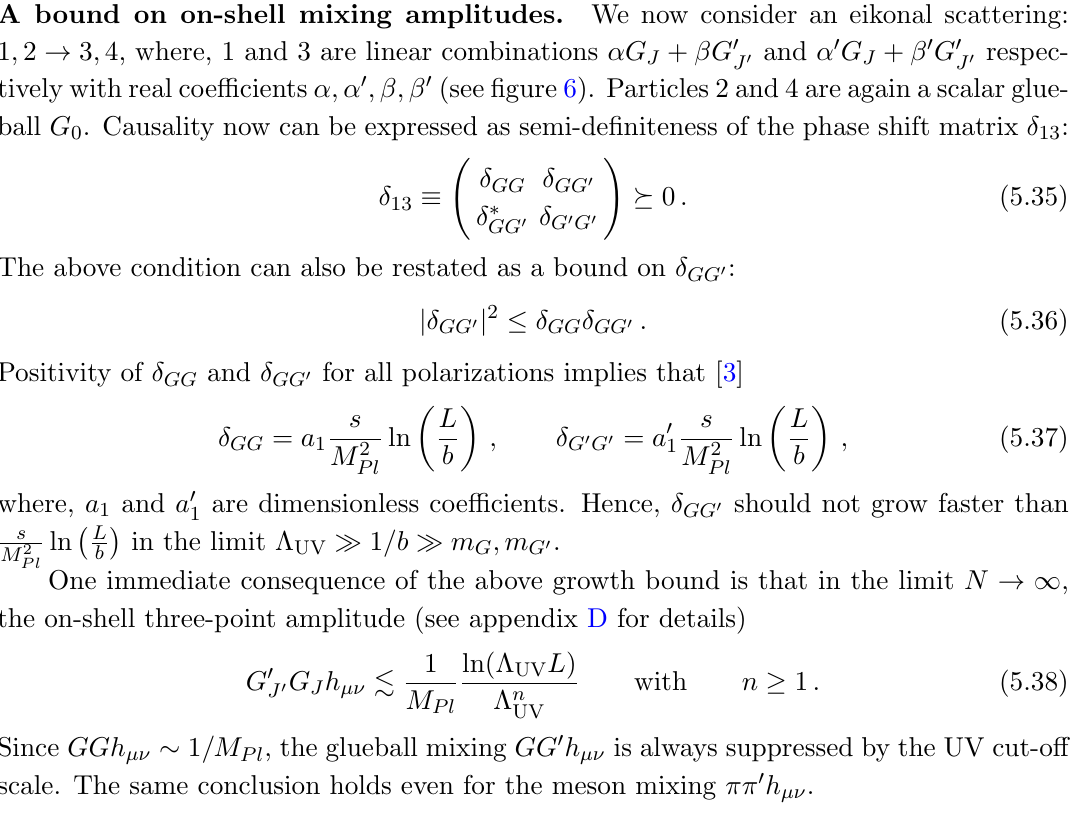
Figure 6 . A setup to bound glueball mixing in large N gauge theories. In the limit N leading non-trivial contribution still comes from a graviton